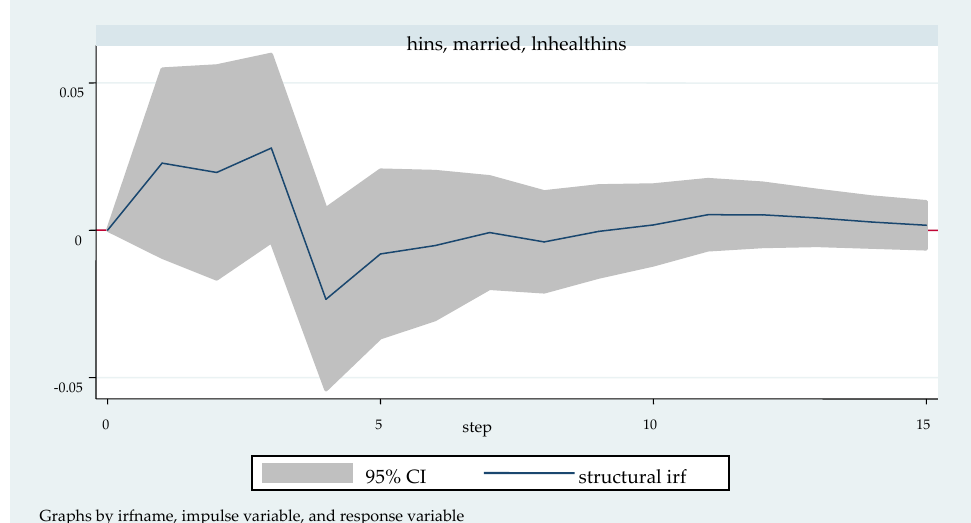
Figure 6. Impulse response function diagram of “lnhealthins” impacted by “edu”.